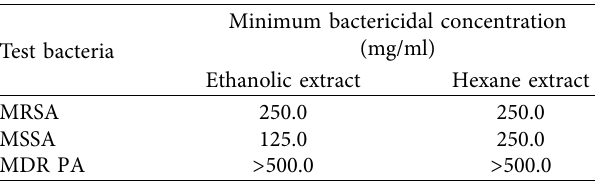
Table 5: Minimum bactericidal concentration (MBC) of the ethanolic and hexane crude extract of A. heterophyllus seeds against selected